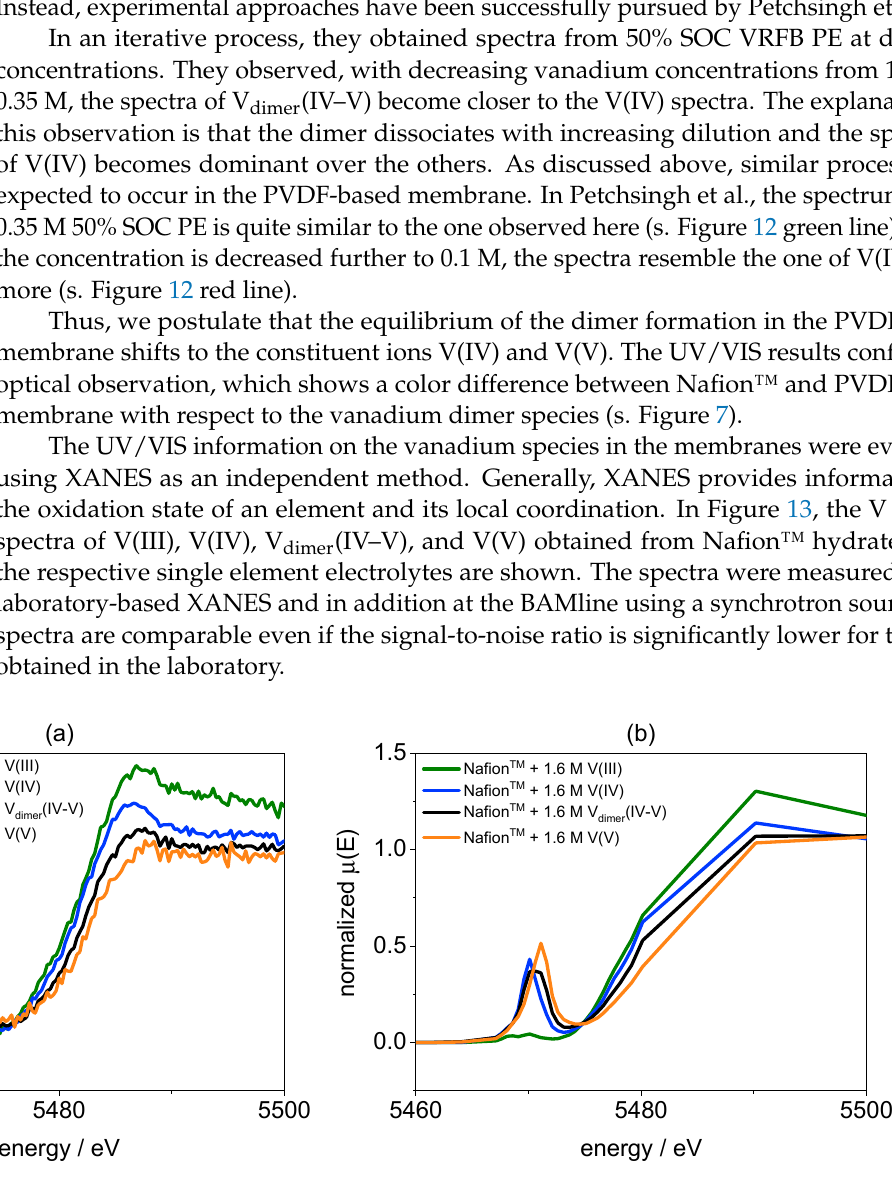
Figure 13. ( a ): V K-edge of Nafion™ hydrated with V(III), V(IV), V dimer (IV–V), and V(V) electrolyte performed using the laboratory-based device easyXES100 (n = 10). ( b ): V K-edge of Nafion™ hydrated with V(III), V(IV), V dimer (IV–V), and V(V) electrolyte performed at BAM line (n = 1).